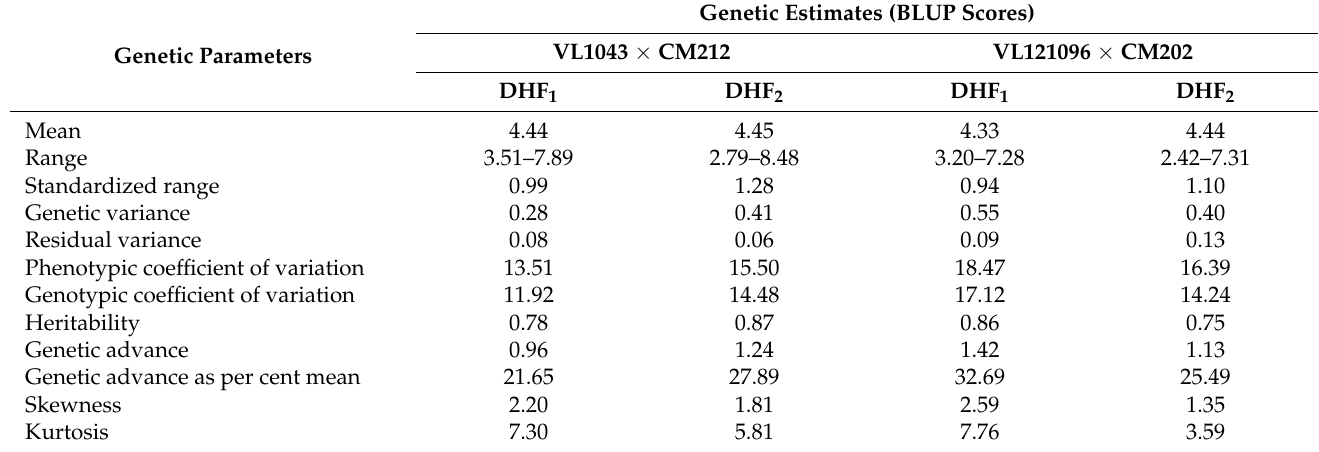
Table 5. Genetic estimates of doubled-haploid lines induced from F 1 and F 2 plants in reaction to FSR disease across two seasons in maize.